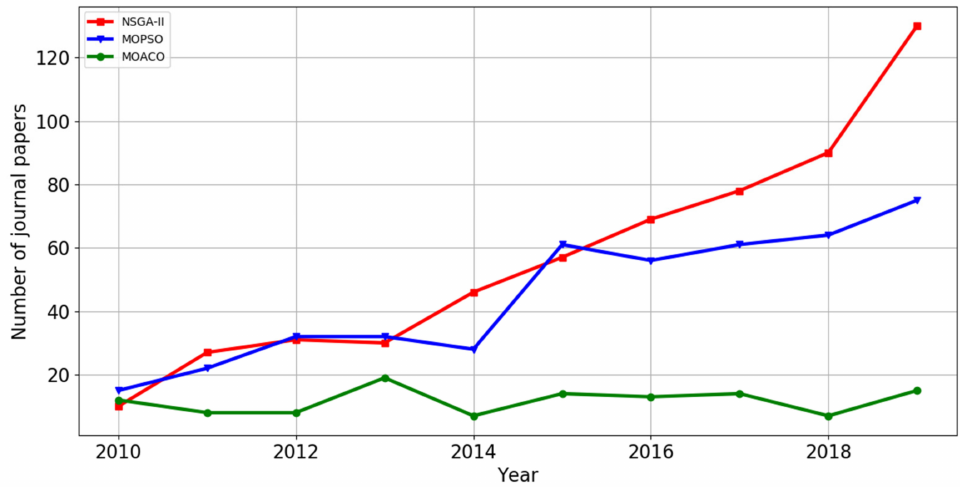
Figure 5. Publication counts of the three most-popular EMO algorithms from 2010 to 2019.